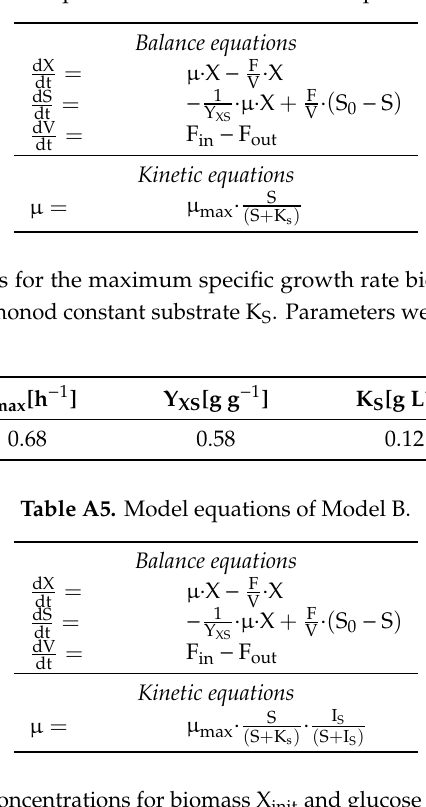
Table A3. Model equations for the initial batch experiment: Model A.